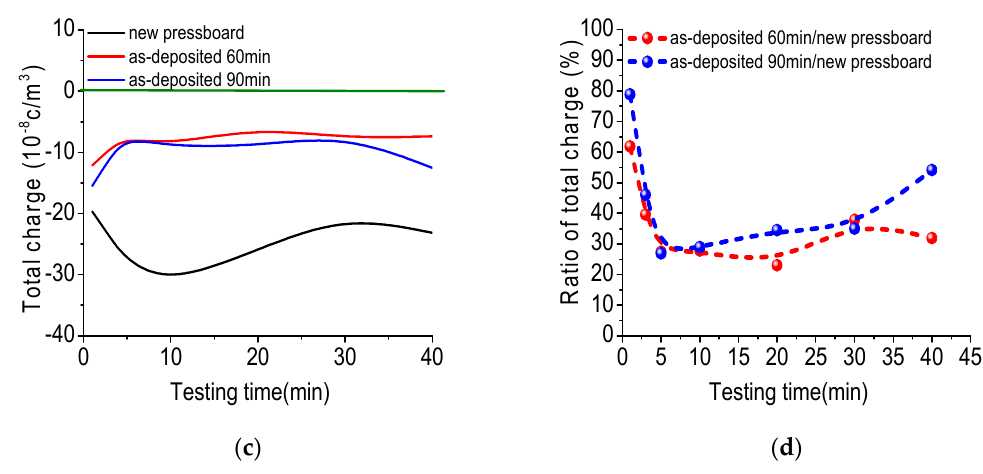
Figure 10. The charge density on the anode and cathode ( a ); the charge density ratio of treated samples to untreated samples ( b ); the total amount of charges trapped in the samples ( c ); and the charges amount ratio of treated samples to untreated samples ( d ) under DC 15 kV/mm.